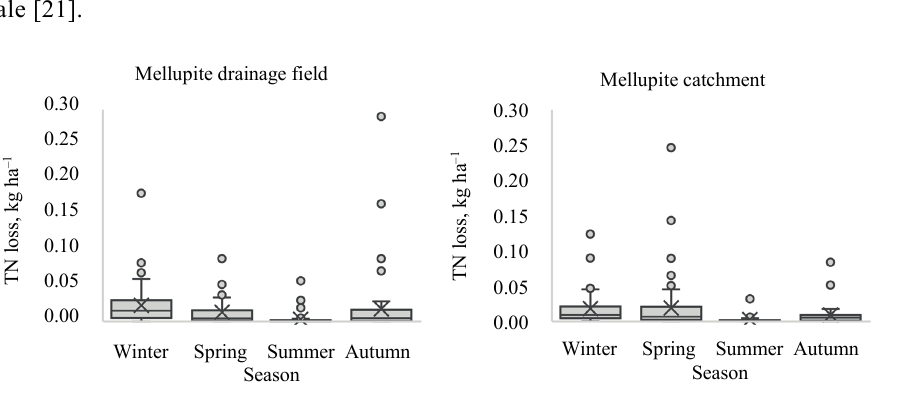
Fig. 7. Seasonal minimum, 25 th percentile, median, 75 th percentile, maximum, outlying values for TP losses (kg ha –1 ) in the Mellupite monitoring site, time period 1995–2020. Overall the values of TP losses fluctuate over time in a narrower range and more evenly distributed through seasons than the corresponding values of TN in the drainage and small catchment scale. The highest TP loss, similar to TN, was observed in winter and the lowest in summer due to reasons explained